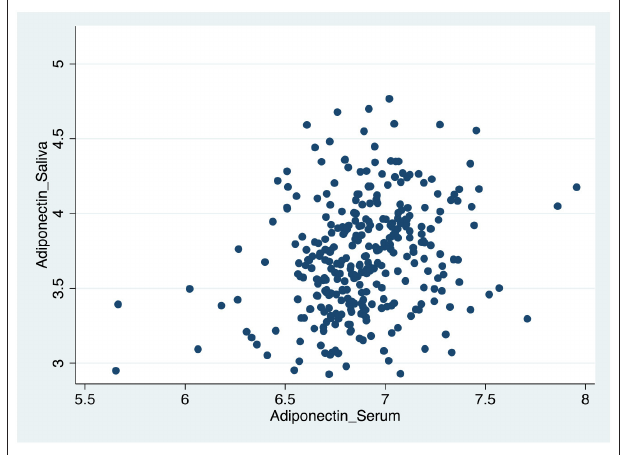
FIGURE 3 | Scatter plot of the correlation between serum and salivary adiponectin biomarker levels.